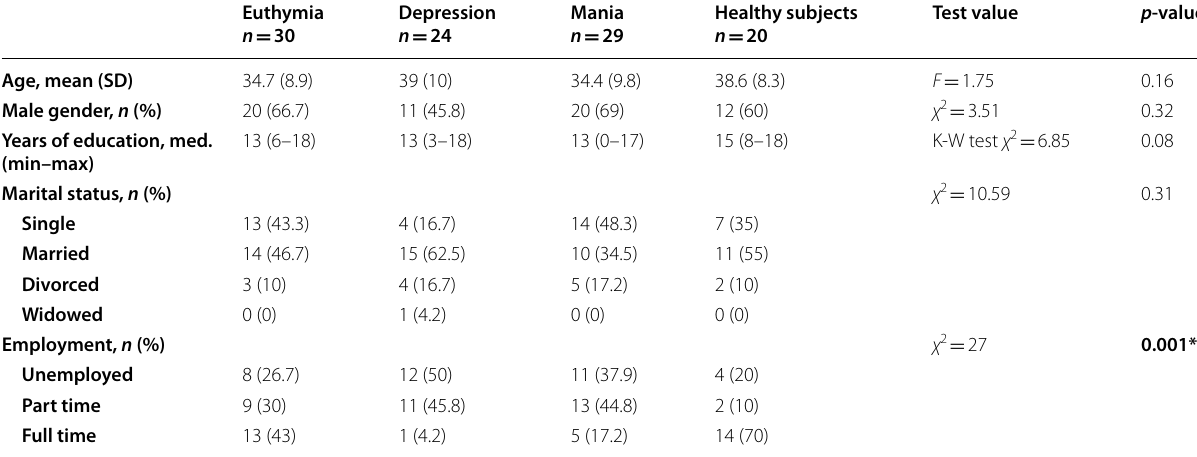
Table 1 Demographic characteristics of the studied groups